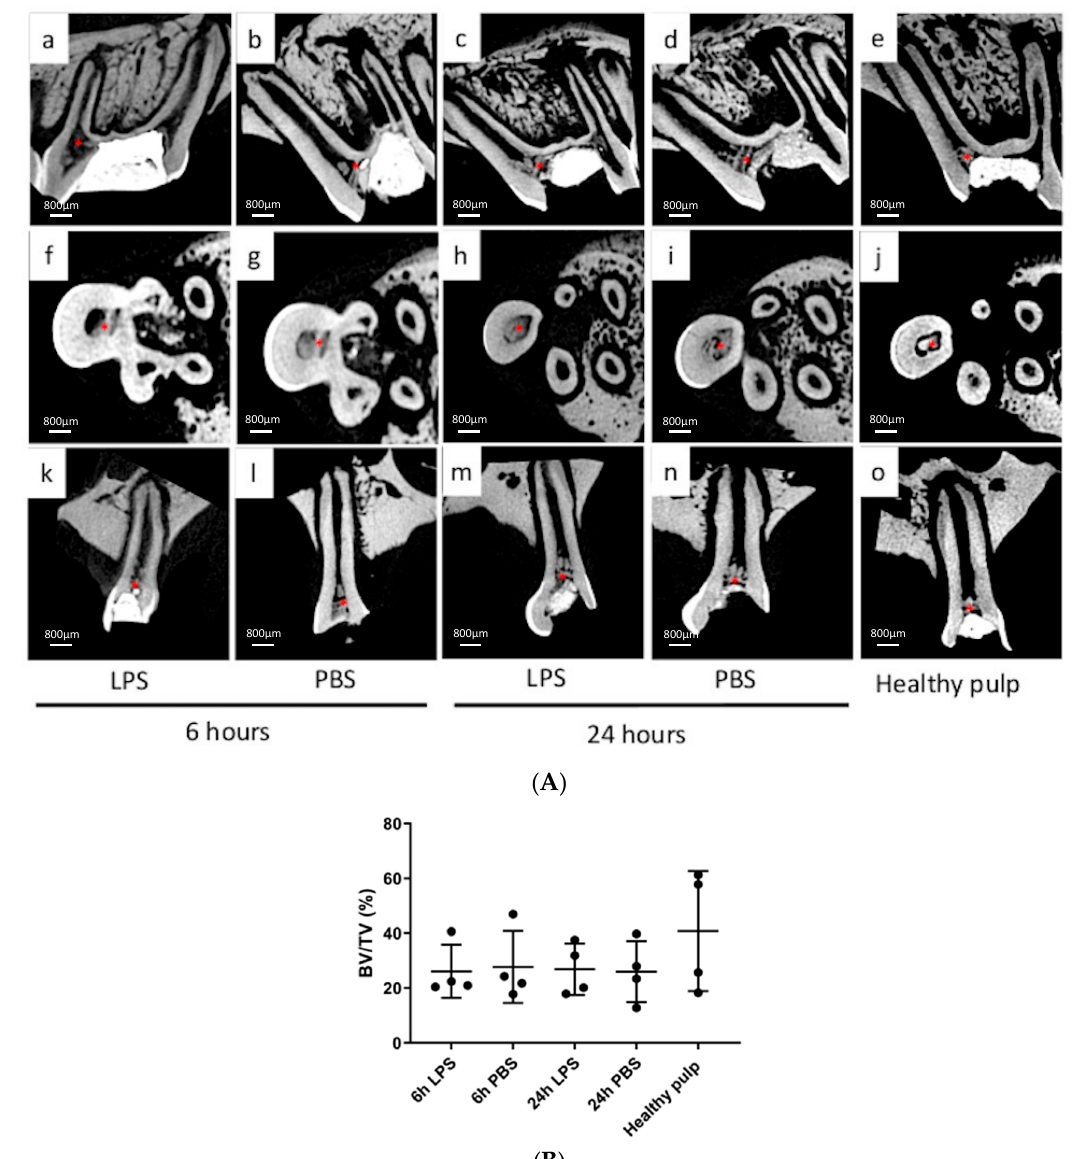
Figure 4. Analysis of mineralized bridge obtained after pulpotomy using tricalcium silicate-based cement by micro-computed tomography. ( A ): The 3D sections focusing on the reparative dentin bridge, 2 weeks after pulpotomy in inflamed teeth (phosphate-buffered saline (PBS) or lipopolysaccharide (LPS)). Thick well-defined calcified tissue (*) was present at the opening of each root, forming a canal obstruction in the control group ( e , j , o ) and in the 6-h LPS/PBS groups ( a , b , f , g , k , l ). The mineralized area seen after 24-h induction ( c , d , h , i , m , n ) looks more heterogenous than after 6-h induction or in healthy pulp. ( B ): Quantification (by Bone volume/Total volume % technique) of the mineralized bridge induced by Biodentine TM 15 days after pulpotomy under different conditions. No significant difference of mineralization was observed between healthy pulp and experimental groups